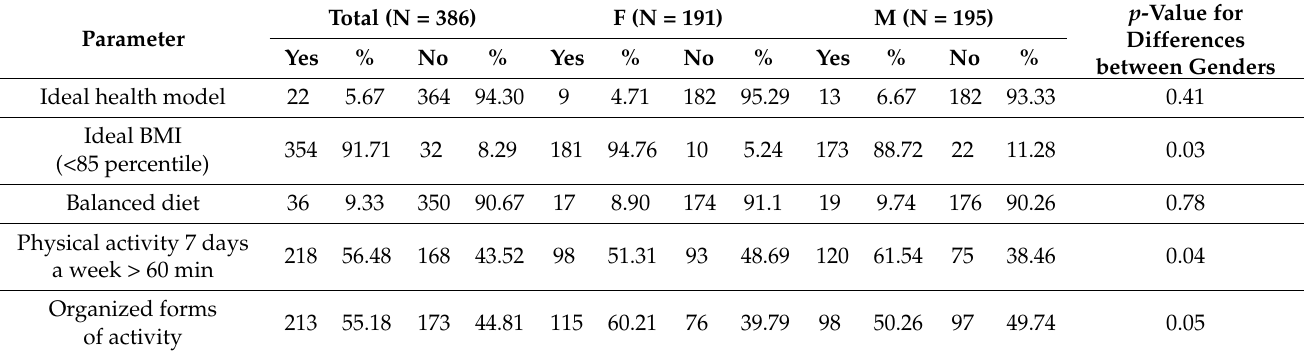
Table 4. Health model and its components with stratification according to gender.